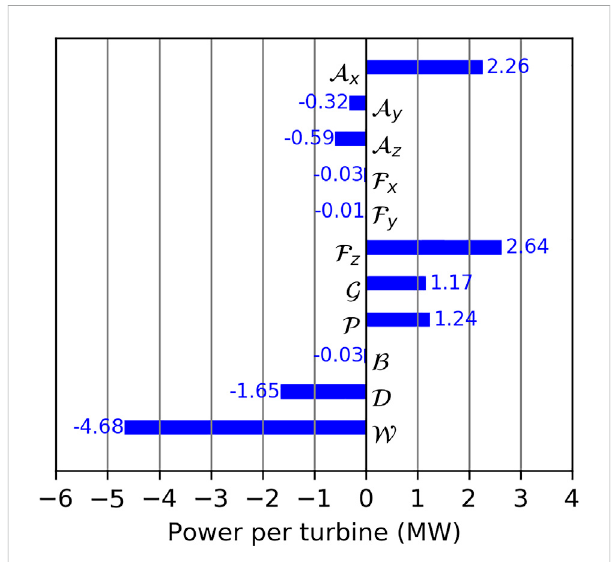
FIGURE 7 Energybudgets inthewindfarmcontrolvolume Ω wf .The budget terms are: advection of KE through the left/right ( A x ) , south/north ) and bottom/top ( A ) boundaries, turbulent fl uxes through the ( A y z left/right ( F x ) , south/north ( F y ) and bottom/top ( F z ) boundaries, geostrophic forcing ( G ) , perturbation pressure gradients ( P ) , dissipation ( D ) and energy extraction by wind turbines ( W )